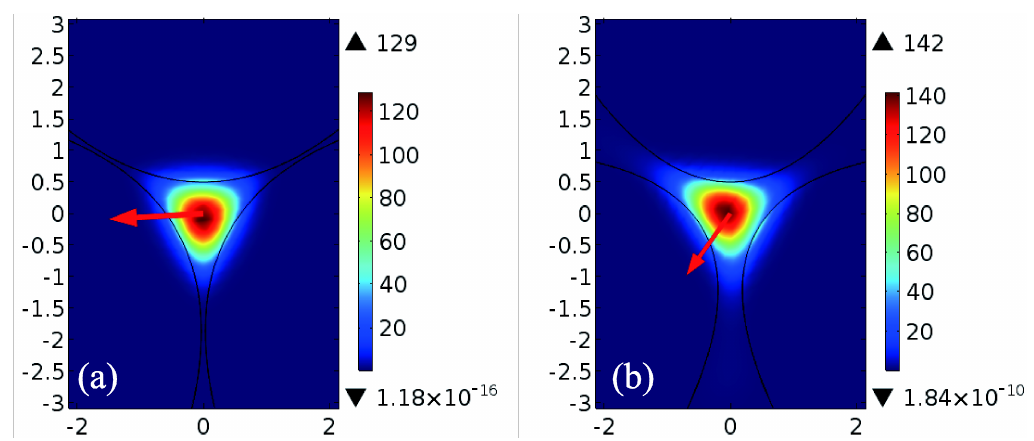
Photonics 2020 , 7 , x FOR PEER REVIEW 9 of 17 Figure 8. Impact of parameter ( a ) a , ( b ) d on the dispersion of FM. Figure 8. Impact of parameter ( a ) a , ( b ) d on the dispersion of FM.